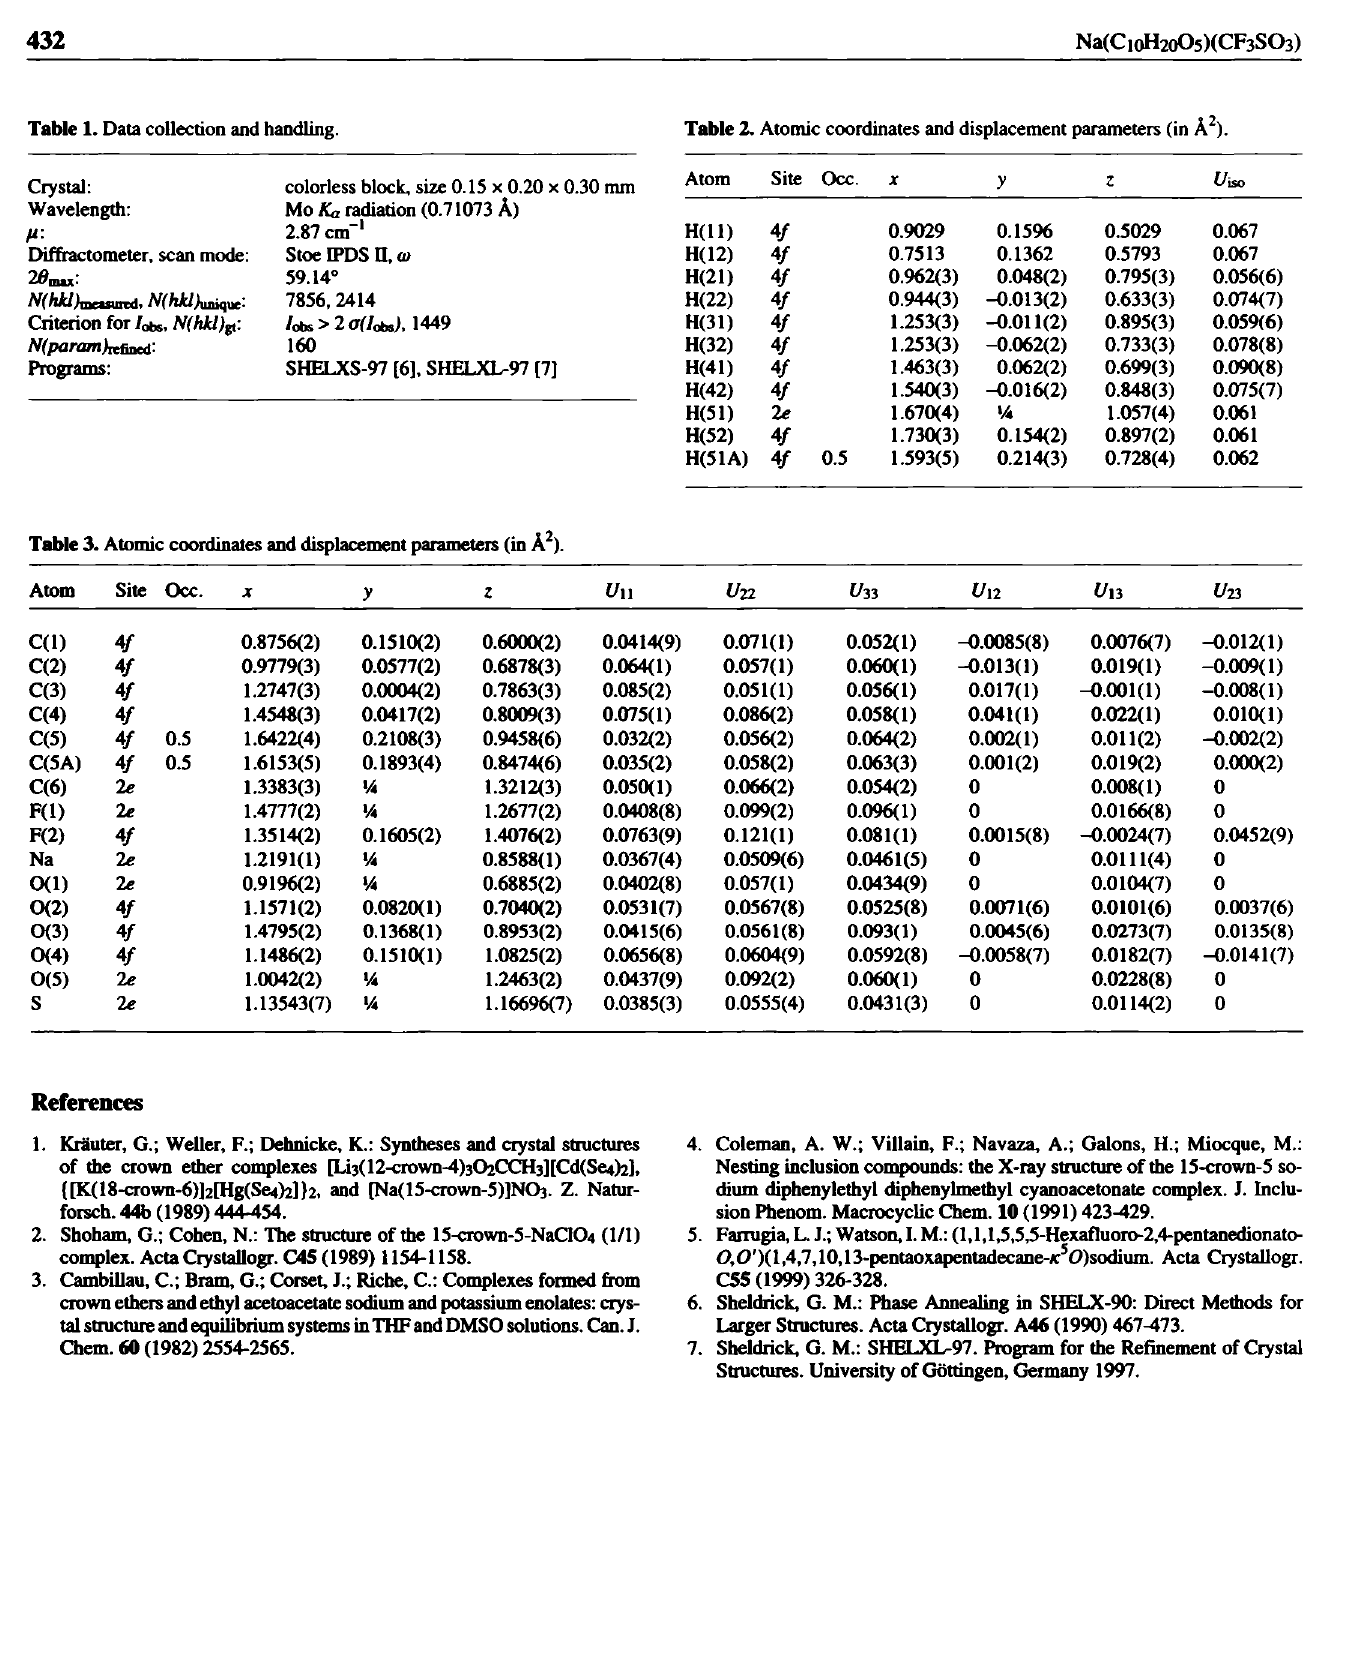
Table 1. Data collection and handling. Table 2. Atomic coordinates and displacement parameters (in A 2 ).